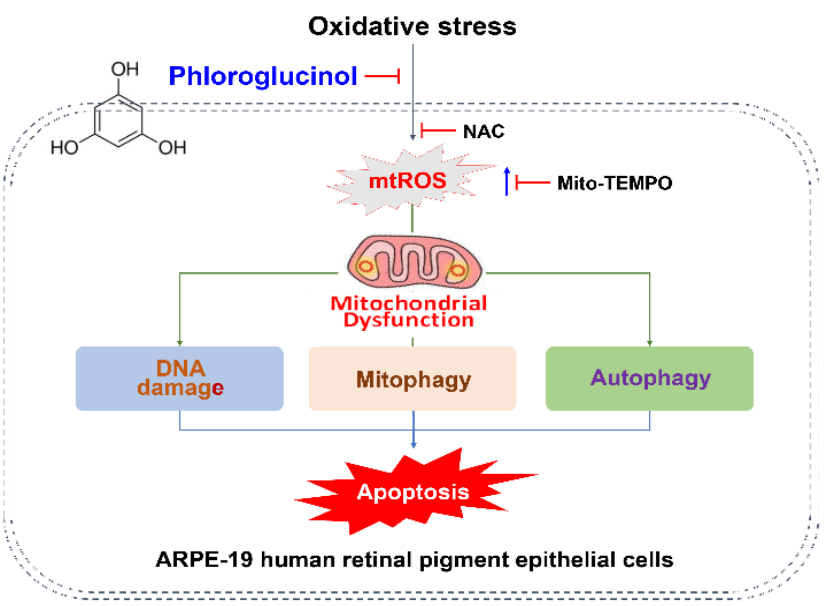
Figure 8. Schematic showing the protective effect of phloroglucinol on oxidative injury in human RPE ARPE-19 cells. As a scavenger of mtROS, phloroglucinol protects against oxidative stress-induced apoptosis by blocking mitochondrial and DNA damage and autophagy.